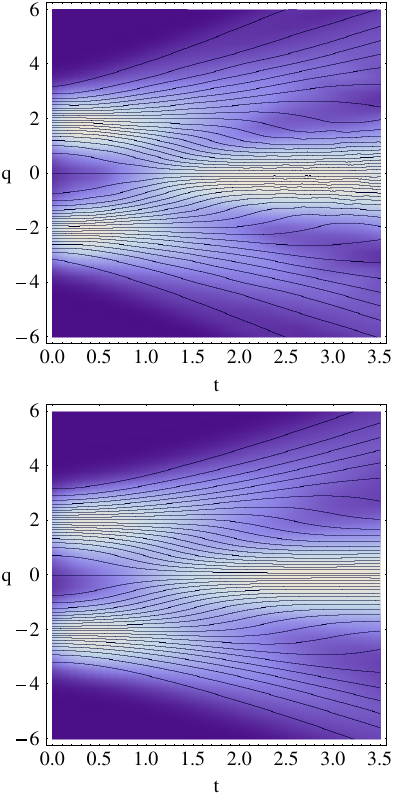
FIG. 6. Trajectory and (smoothed) density plots of the com- puted MIW (top) and dBB (bottom) world trajectories for two identical initial Gaussian wave packets in units of the initial spread (i.e., σ ¼ 1 ) and N ¼ 41 worlds; time is given in units of ℏ = ð 2 m Þ .